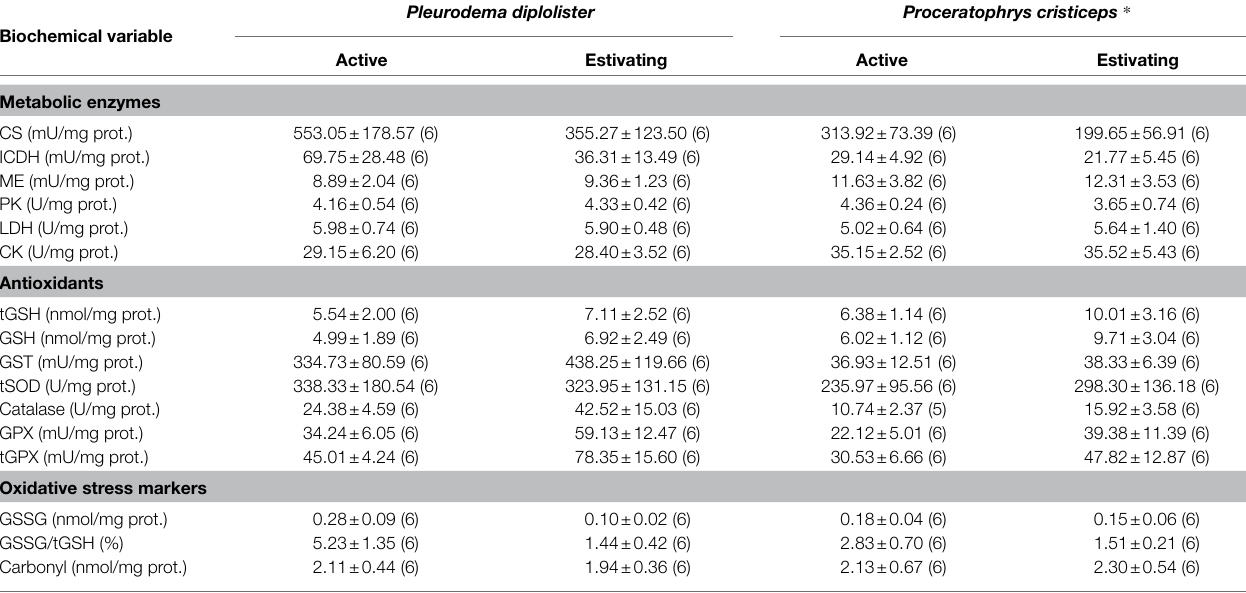
TABLE 1 | Biochemical variables measured in the skeletal muscle of free-ranging Pleurodema diplolister and Proceratophrys cristiceps collected during the rainy (active) and the dry season (estivating) in the Caatinga. Pleurodema diplolister Biochemical variable Estivating Estivating Metabolic enzymes